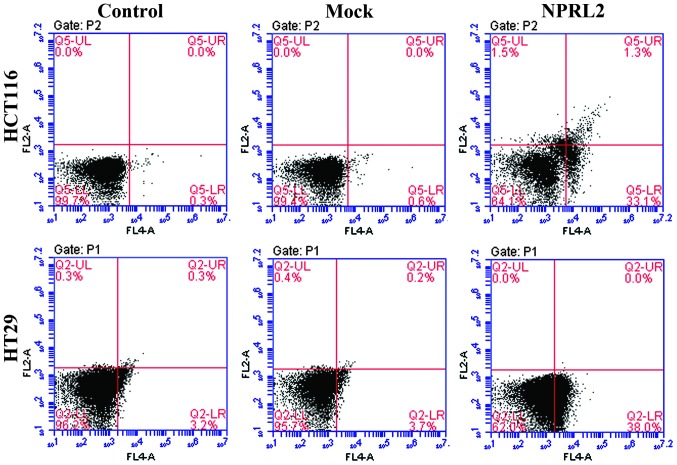
Effects of the overexpression of NPRL2 on apoptosis. Flow cytometric analysis revealed that the NPRL2-transfected groups exhibited a marked increase in apoptosis, compared with the mock-transfected and control groups. Upper left quadrant, necrotic cells; lower left, normal cells; upper right, early apoptotic cells; lower right, late apoptotic cells. Control, cells without transfection; Mock, cells transfected with mock vector; NPRL2, cells transfected with NPRL2-overexprseeion vector. Control, cells without transfection; mock, cells transfected with mock vector; NPRL2, cells transfected with NPRL2-overexpression vector. NPRL2, nitrogen permease regulator like-2.